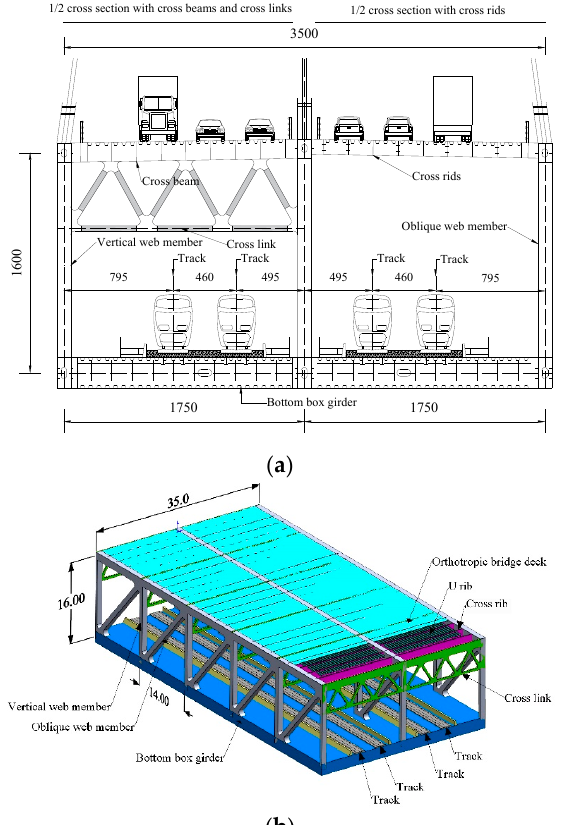
Figure 1. Cross section of the roadway-railway truss bridge: ( a ) girder cross section (unit: cm) and ( b ) 3D bridge girder with 5 truss units (unit: m).